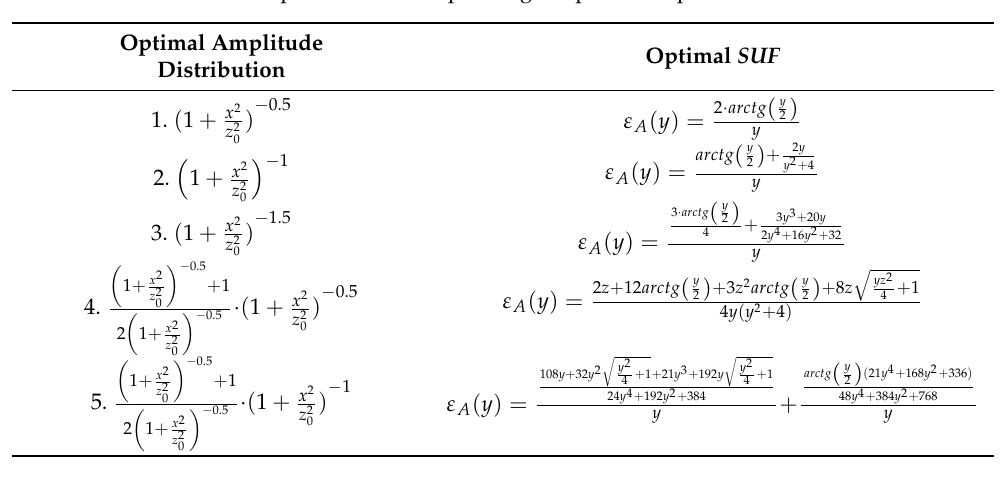
Table 1. Values of the SUF parameter corresponding to optimal amplitude distributions.